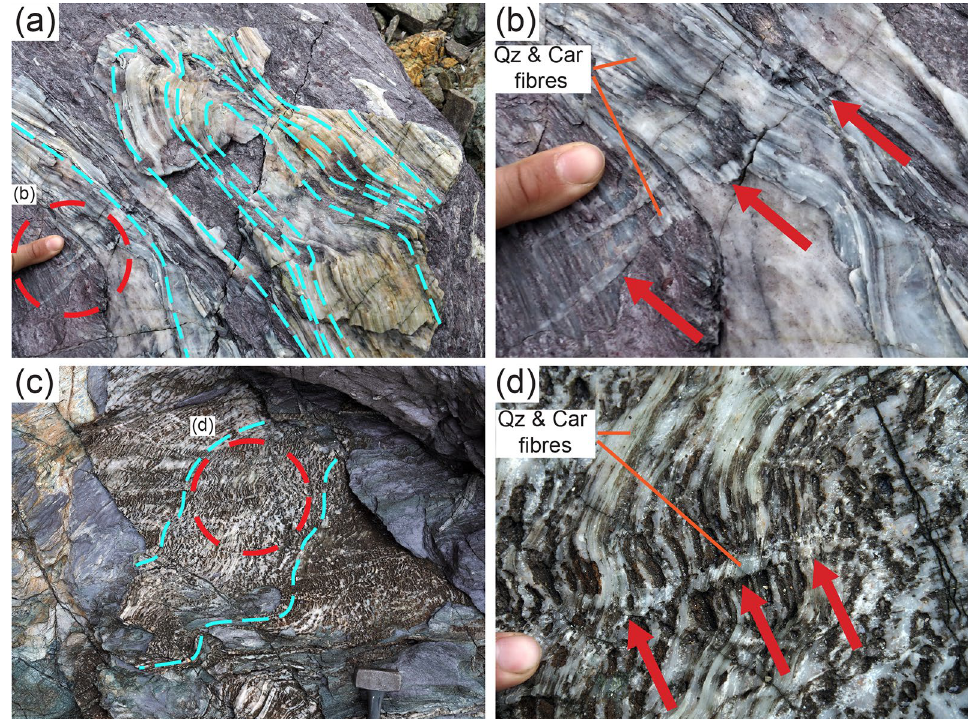
Figure 6. Non-cylindrical folding of dilational hydroshear veins cut by a younger generation of quartz and carpholite veins (red arrows) in metaconglomerate ( a , b ) and metapelite ( c , d ). The dashed light blue lines indicate the orientation of quartz and carpholite fibres in folded dilational hydroshear